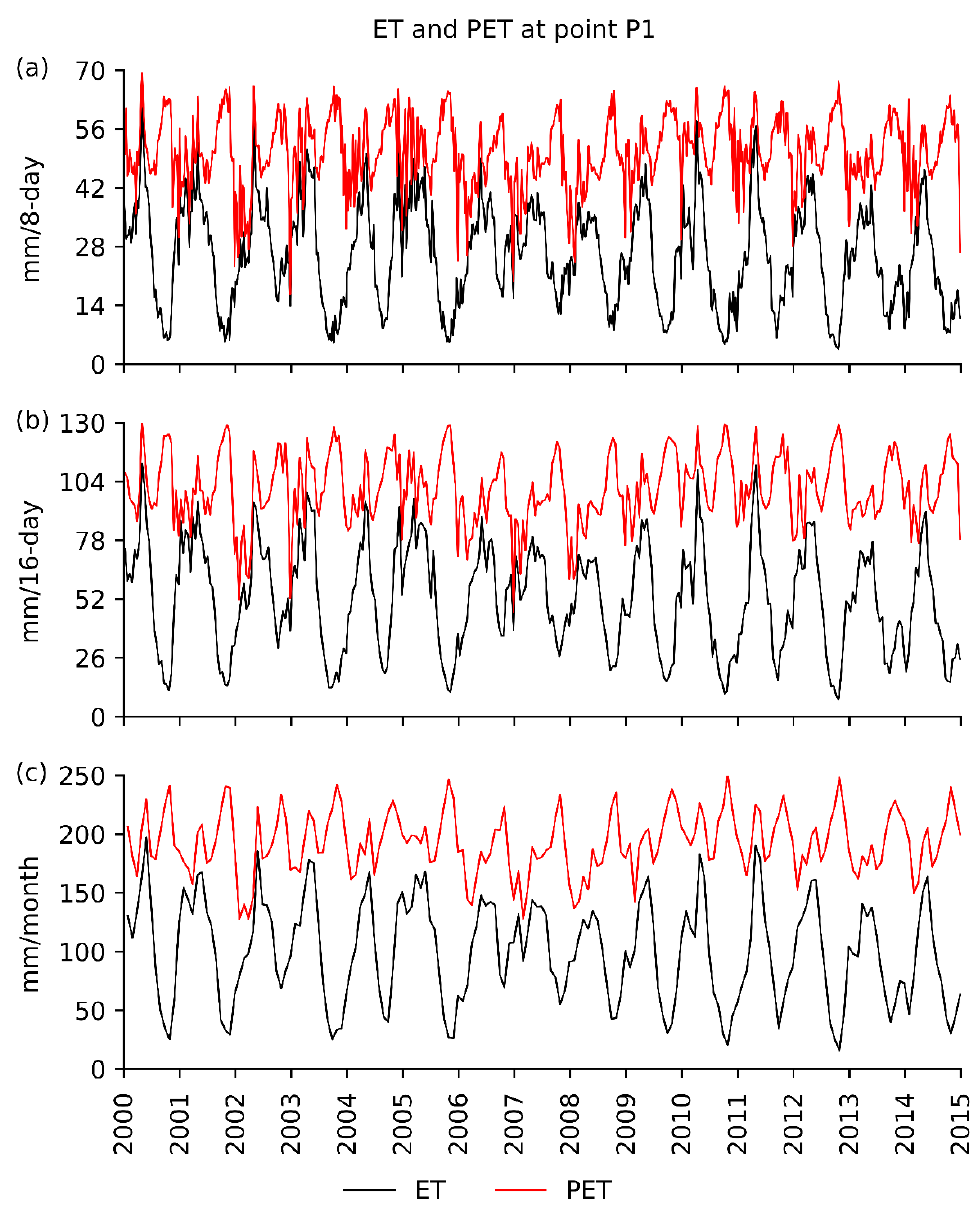
Figure 2. Typical Moderate Resolution Imaging Spectroradiometer (MODIS) evapotranspiration (ET) and potential evapotranspiration (PET) time series at ( a ) 8-day, ( b ) 16-day, and ( c ) 1-month temporal scales [26] at point P1 in the Ruvu River basin.